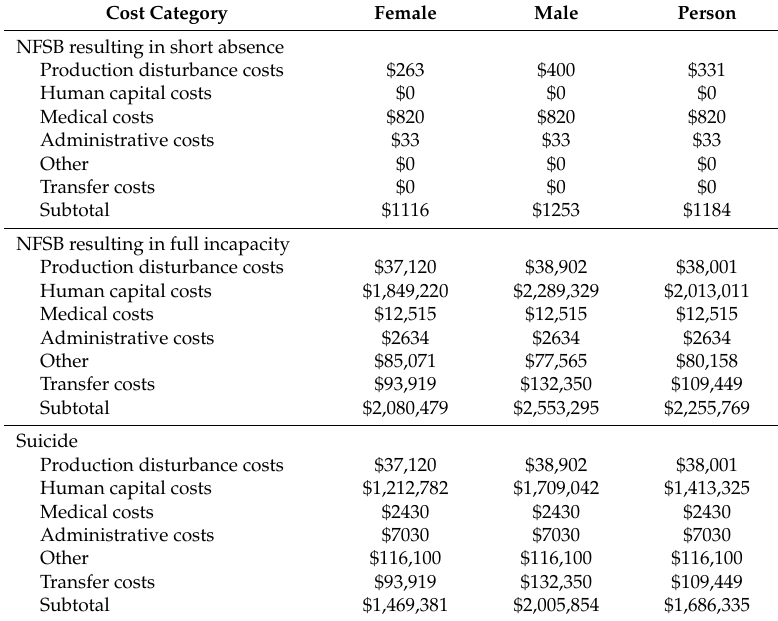
Table 5. Average cost of suicide and non-fatal suicide behavior (NFSB) by gender, 2014. Cost Category Female Male